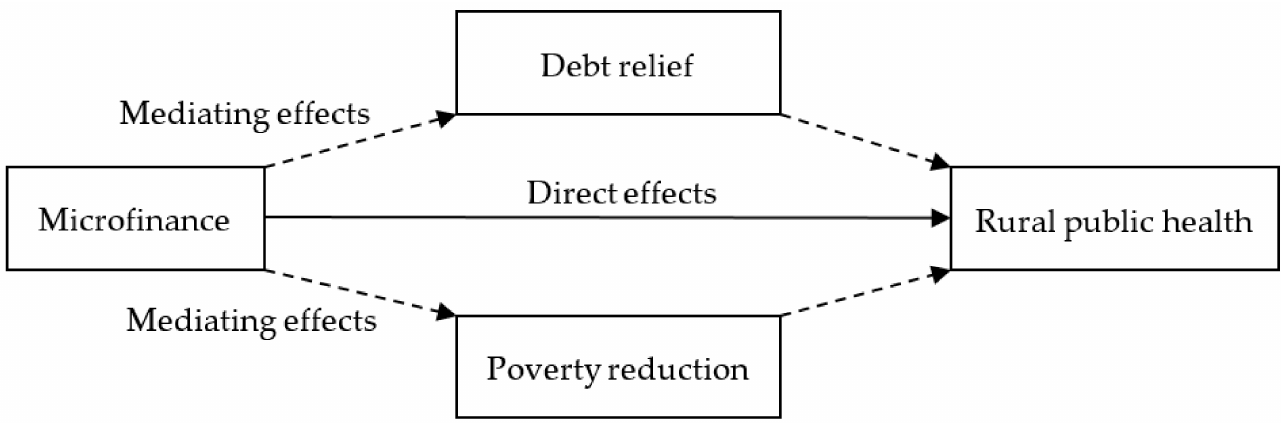
Figure 1. Mediation